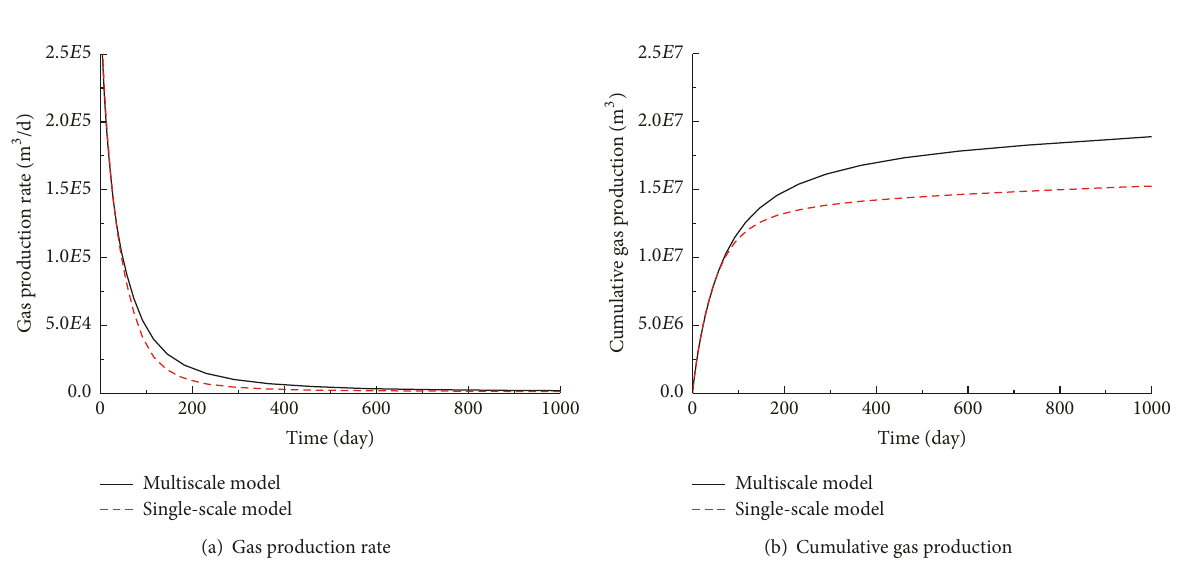
Figure 14: Comparison of gas production prediction by multiscale and single-scale